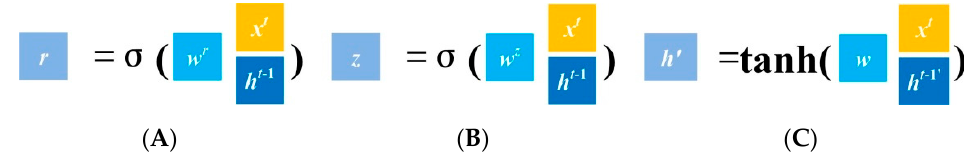
Figure 5. Gated information. ( A ) current gates state; ( B ) update gated state; ( C ) current transmitted state.